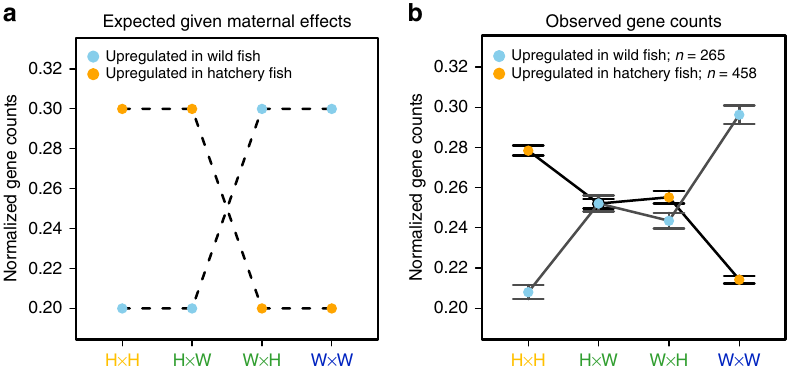
Figure 2 | Examination of maternal effects using reciprocal crosses. Here ‘‘upregulated’’ means more highly expressed in that group. ( a ) Expected pattern of DE genes for purely maternal effects. The offspring of H (cid:2) H and H (cid:2) W crosses shared a mother. The offspring of the W (cid:2) H and W (cid:2) W crosses also shared a mother (See Fig. 1). If there were maternal effects, we would expect, after normalizing counts across all DE genes, that the offspring of H (cid:2) W crosses would be more similar to the H (cid:2) H offspring and that the offspring of the W (cid:2) H fish would be more similar to the W (cid:2) W fish. ( b ) We observed that most of the genes have an additive effect, in that expression values for H (cid:2) W and W (cid:2) H offspring are intermediate. Bars represent 95% confidence intervals for all DE genes (n ¼ 723). This result suggests that very few genes are DE due to maternal